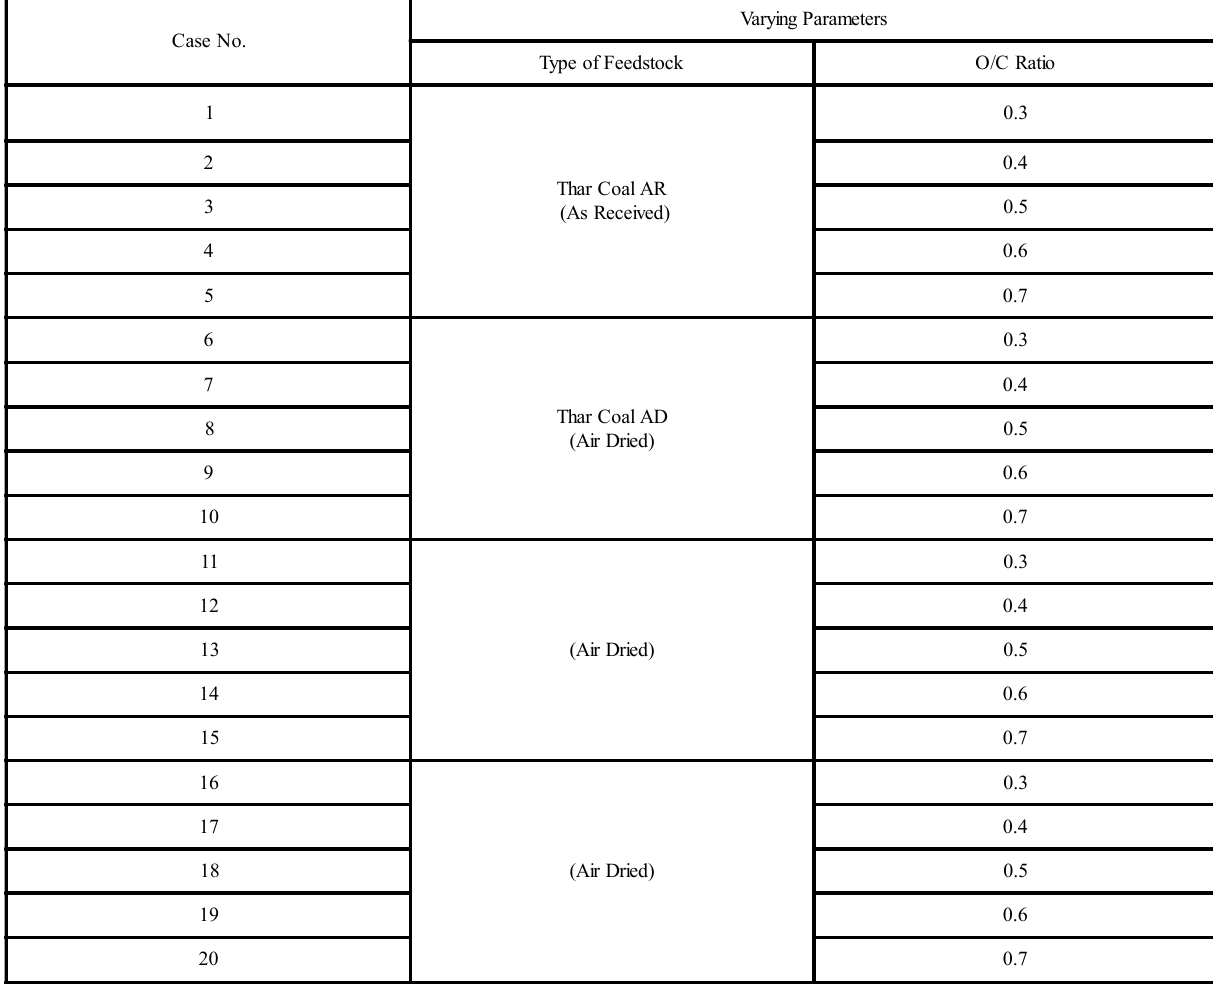
TABLE 8. THE CASE PARAMETERS OF VARYING INPUT FOR ALL